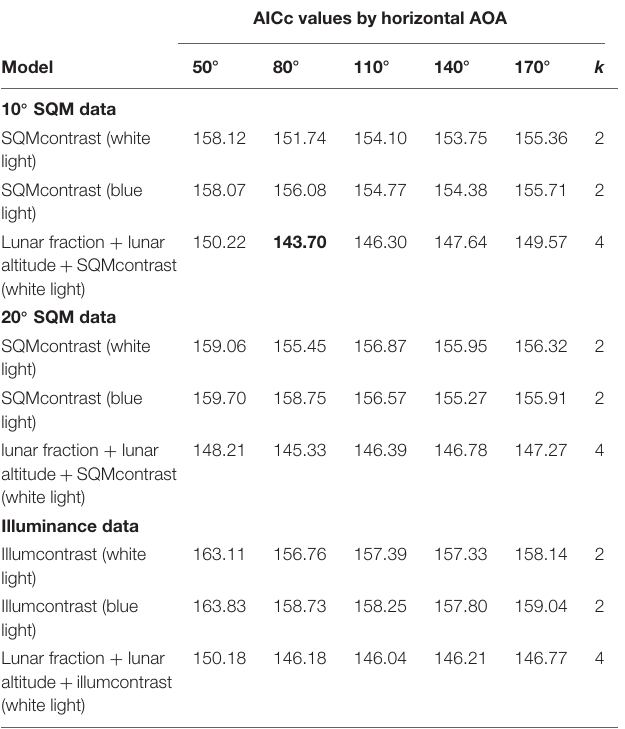
Lower AICc values indicate the associated model has better support from the data than models with higher AICc values, k denotes the number of estimated parameters in the model. All models included an intercept, the bolded value is the AICc for the best model. The additive lunar fraction + lunar altitude + SQMcontrast (white light) model has the lowest AICc value and is the top ranked model; larger lunar fractions, lower lunar altitudes, and larger SQMcontrast values reduced misorientation.